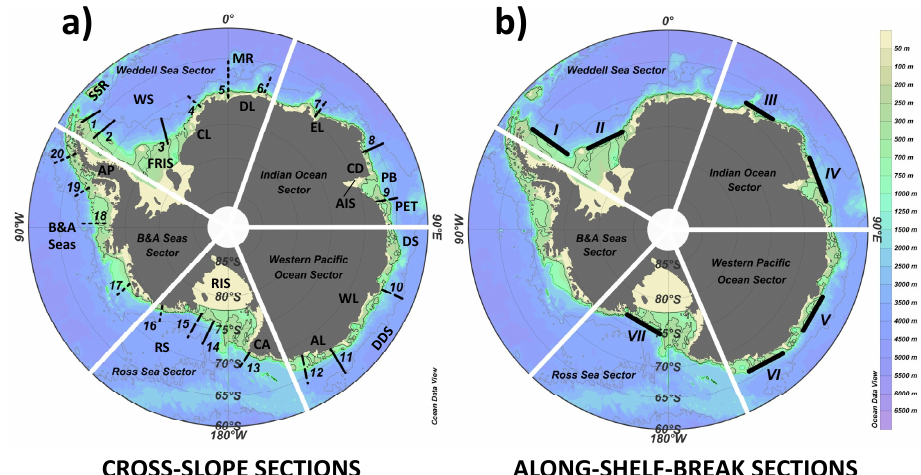
CROSS ‐ SLOPE SECTIONS ALONG ‐ SHELF ‐ BREAK SECTIONS Fig. 1. Southern Ocean sectors with (a) cross-slope sections and (b) along-shelf-break sections. The thin black, green, and grey lines are the 500m, 1000m and 4000m isobaths. The black thick, dashed and dotted lines in (a) denote regions of active, passive and null Antarctic Bottom Water downslope flow, respectively. Adelie Land Coast = AL, Amery Ice Shelf = AIS, Antarctic Peninsula = AP, Bellingshausen and Amundsen = B&A, Cape Adare = CA, Cape Darnley = CD, Coats Land = CL, Dumont d’Urville Sea = DDS, Dronning Maud Land = DL, Davis Sea = DS, Enderby Land Coast = EL, Filchner-Ronne Ice Shelf = FRIS, Maud Rise = MR, Prydz Bay = PB, Princess Elizabeth Trough = PET, Ross Ice Shelf = RIS, Ross Sea = RS, South Scotia Ridge = SSR, Wilkes Land Coast = WL, Weddell Sea =